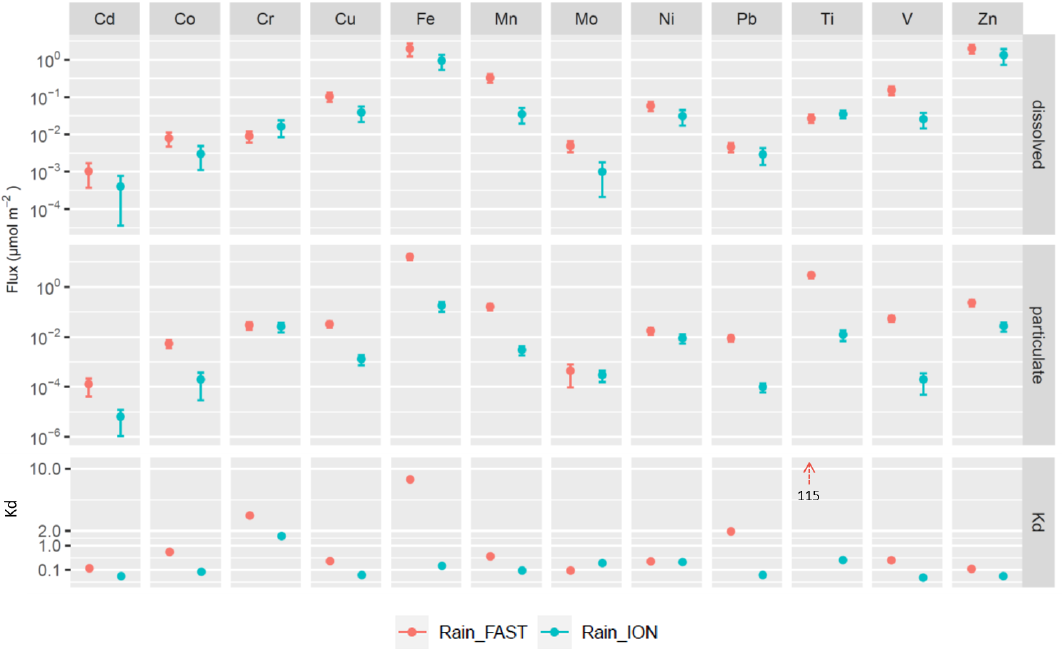
Figure 8. Dissolved (upper row) and particulate (middle row) wet deposition fluxes (µmolm − 2 ) and Kd (lower row) for the different TMs estimated from the two rains sampled on board, taking into consideration the standard deviation of the TM concentrations and the spatial variability of total precipitation over the area of sampling (Rain ION is shown in blue, and Rain FAST is shown in red). Note the different scales of the y axes and that the Kd value for Ti (115) in Rain FAST is out of